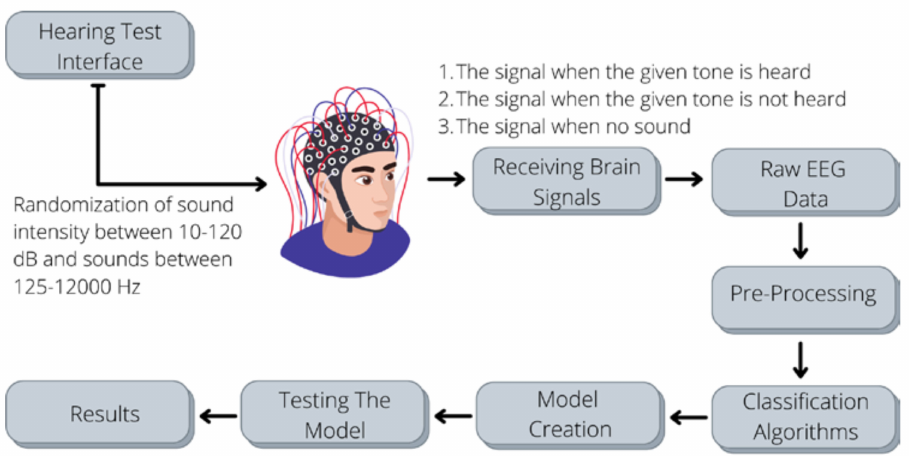
Figure 1. The proposed procedure in our